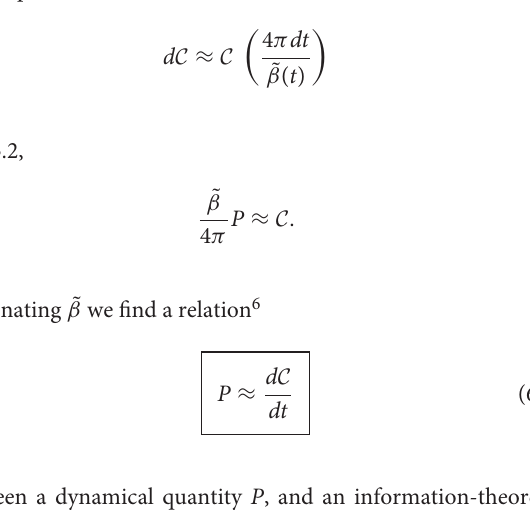
applying a fermion operator the SYK low temperature state ground